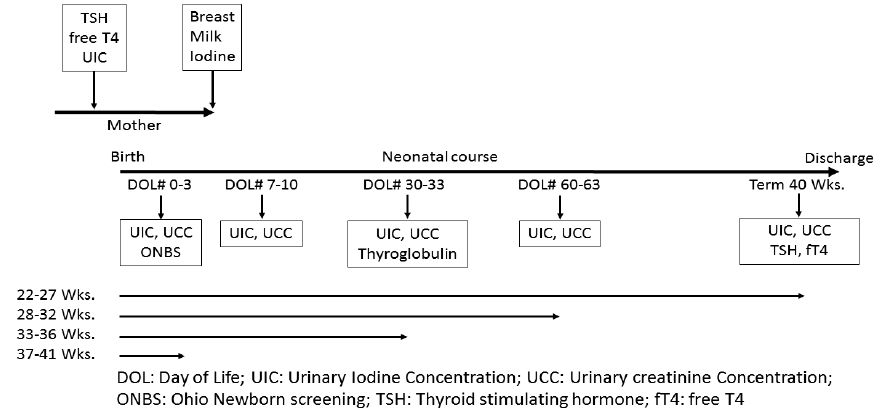
Figure 1. Flow diagram showing timing of laboratory assays in various gestational age subjects.